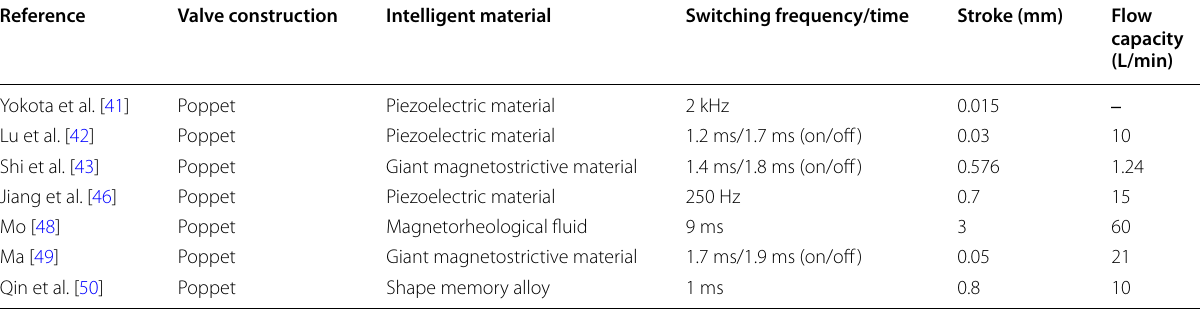
Table 3 Summary of the HSVs with intelligent